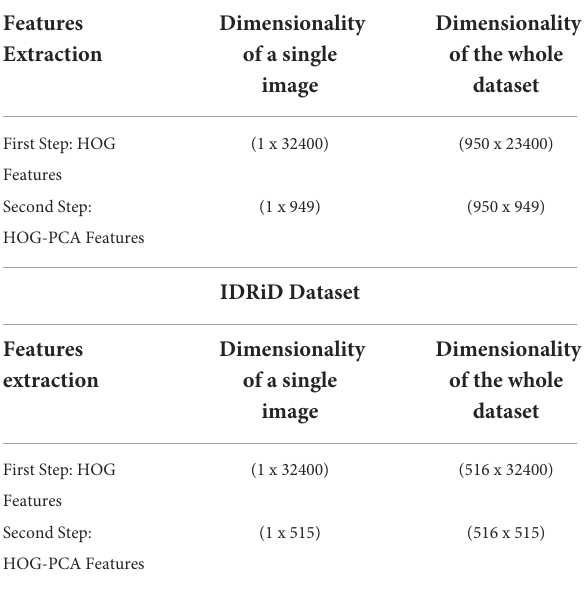
TABLE 4 Elaborate the features extraction step dimensionality for single image and whole dataset images. APTOS-2019 Dataset